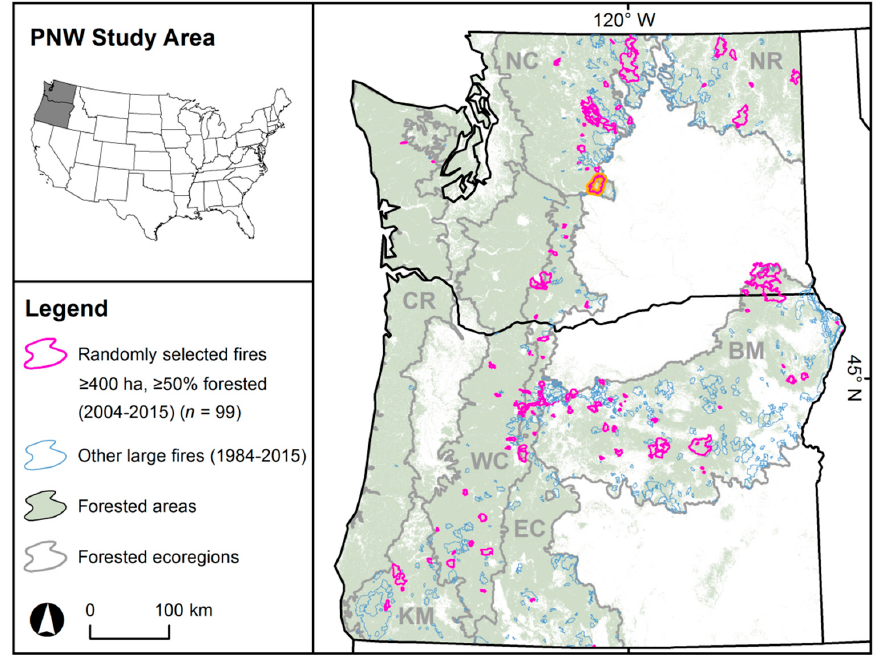
Figure 2. Study area and fires of interest across Oregon and Washington. Pink polygons are the randomly selected portions of large wildfires ( ≥ 400 ha) with ≥ 50% forest cover that burned only once from 2004 to 2015 ( n = 99). Study fires occurred primarily east of the Cascade Range. Dark blue polygons are all MTBS fires that burned between 1984 and 2015 within generally forested ecoregions (level three [44]). The orange perimeter indicates location of the Table Mountain Complex (Figures 3 and 4). Oregon and Washington encompass ca. 40 M ha total and 20 M ha of forest (light green areas indicate forest cover [38]). Ecoregion abbreviations: NC: North Cascades; NR: Northern Rockies; CR: Coast Range; BM: Blue Mountains; WC: West Cascades; EC: East Cascades; KM: Klamath Mountains.